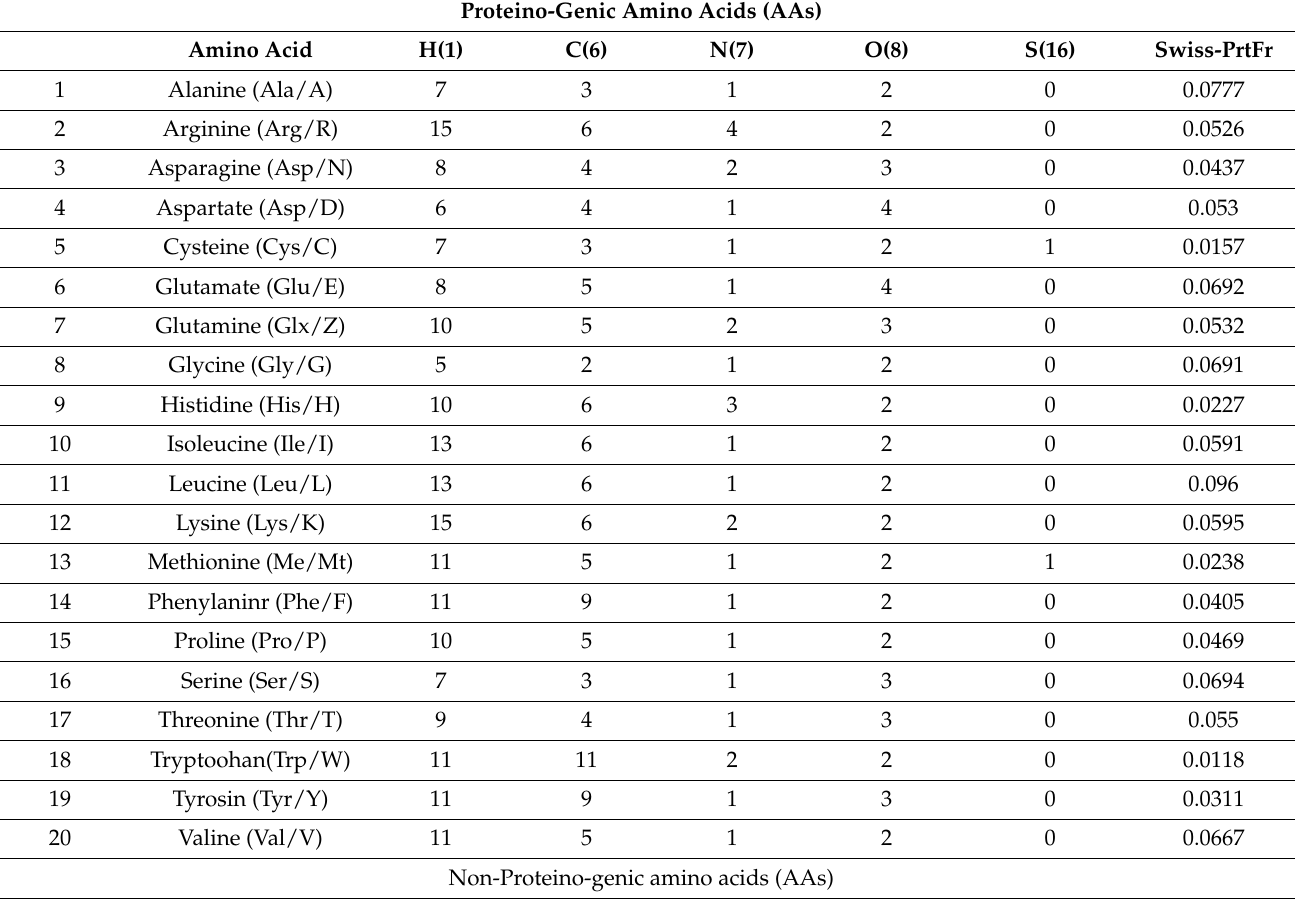
Table 1. Atomic content of the proteinogenic AAs (oxygen (O), carbon (C), nitrogen (N) sulfur(S) and hydrogen (H) atoms) and their frequency distribution in protein sequences found in the Swiss-Prot. database (Swiss-ProtFraction). Adopted with modification from